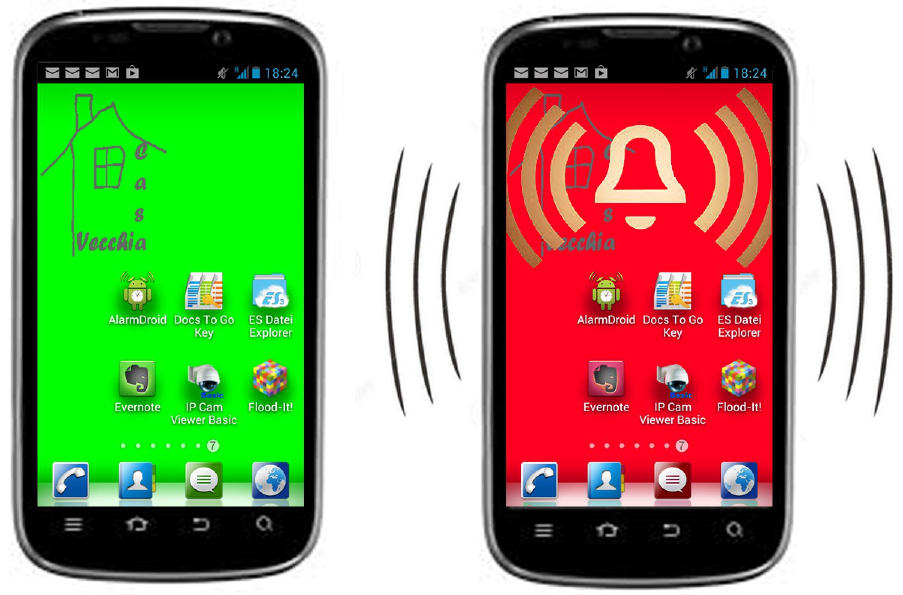
Figure 4. Smartphone of trusted person with different background colors and alerting